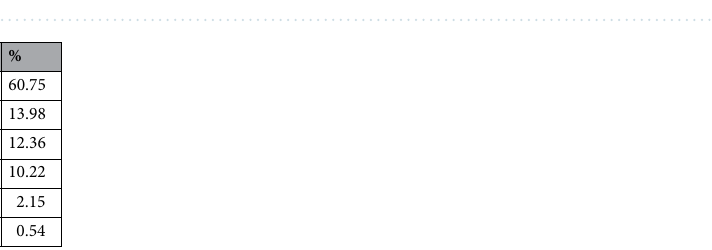
Figure 4. Micro-CT images showing the root canal configuration of the analyzed teeth using Vertucci’s criteria (above) and Ahmed’s criteria (below). D distal; M mesial; MP mandibular first premolar (Images obtained using the CTAn v.1.12 software, Bruker).